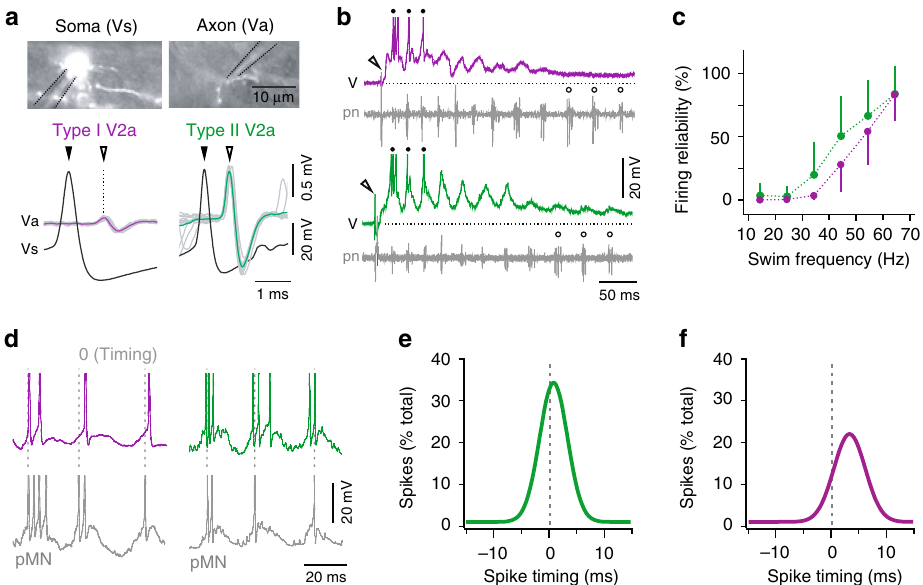
Fig. 2 Distinct V2a neuron types are recruited at higher swimming frequencies. a Top, images of type I V2a neuron mosaically labeled with green fl uorescent protein to obtain simultaneous intracellular somatic (Vs) and extracellular axonal (Va) recordings for conduction velocity measurements. Dashed lines indicate recording electrodes. Bottom, intracellular somatic and extracellular axonal recordings from type I and II V2a neurons. Somatic spikes are presented as mean waveform ( fi lled arrowheads), while for axonal spikes the mean (open arrowheads) is superimposed on individual traces (gray). b Top, simultaneous current-clamp recordings from a type I V2a neuron (V) and extracellular recordings of peripheral motor nerves (pn) during fi ctive swimming following a brief electrical stimulus to the skin (open arrowhead). Filled circles highlight suprathreshold swimming frequencies, while open circles highlight examples of subthreshold frequencies. Spikes are truncated to better reveal the underlying synaptic drive. Dashed line indicates resting membrane potential, − 53 mV. Bottom, as above but for a type II V2a neuron. Resting membrane potential, − 70 mV. c Quanti fi cation of the reliability of fi ring as a function of swimming frequency for type I ( n = 21) and type II ( n = 55) V2a neurons. Data are reported as means ± standard deviations. Source data are provided in a Source Data fi le. d Current clamp recordings of excerpts of suprathreshold rhythmic activity during fi ctive swimming recorded from type I (left) and type II (right) V2a neurons and a primary motor neuron (pMN) in the same spinal segment. Spikes are truncated to better reveal the underlying synaptic drive. Gray dashed lines indicate the fi rst spike in the pMN used to calculate V2a spike timing. e A gaussian fi t of spike timing relative to the fi rst spike in a local primary motor neuron (0, dashed line) for type II V2a neurons ( n = 7). See Methods for details. Source data are provided in a Source Data fi le. f As in panel e , but for type I V2a neurons ( n =